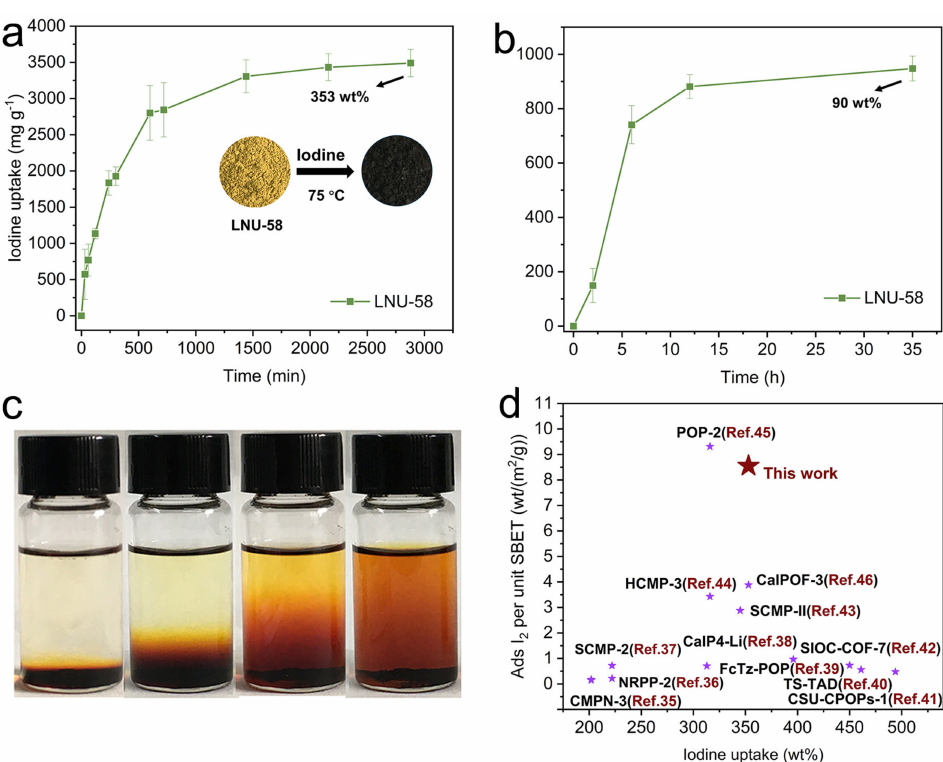
Figure 4. ( a ) Gravimetric I 2 uptake of LNU-58 as a function of time at 75 ◦ C. Photograph inserts show the color change of LNU-58 before and after iodine sorption; ( b ) iodine uptake of LNU-58 as a function of time from iodine aqueous solution; ( c ) photographs indicate gradual changes in iodine desorption processes of LNU-58; ( d ) comparison of iodine uptake capacities with other bench